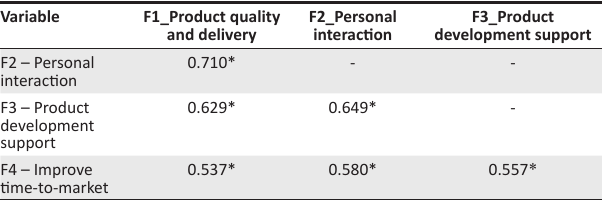
TABLE 5: Pearson’s